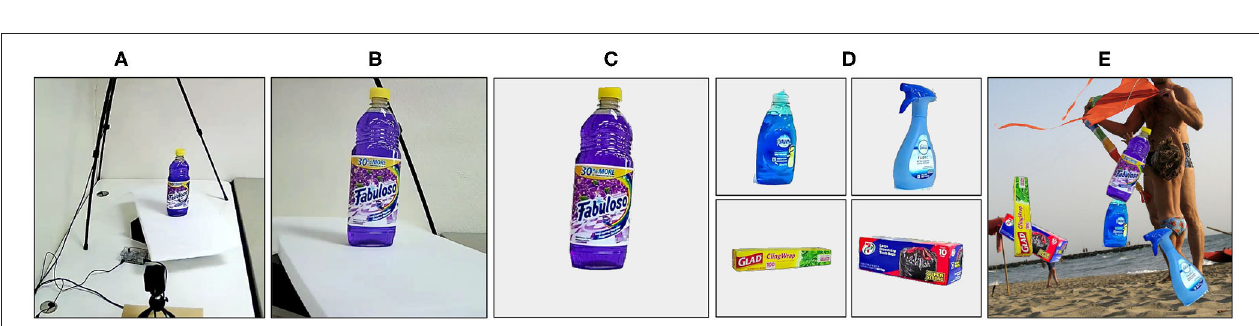
FIGURE 7 | An example of the data generation for training. We collected videos of the items from three different angles shown in (A) . (B) Illustrates the view from one of camera angles. From (B) we removed the background (C) and overlaid the multiple cropped objects (D) onto images from the COCO Dataset ( Lin et al., 2014). Finally, a Faster R-CNN (Ren et al., 2015) model was trained with 30k images like (E)